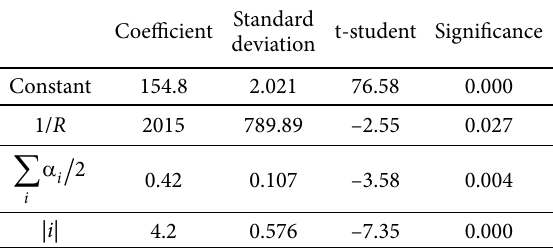
Table 5. Comparison between ‘observed V 85 ’ and ‘normal V 85 ’ Section location